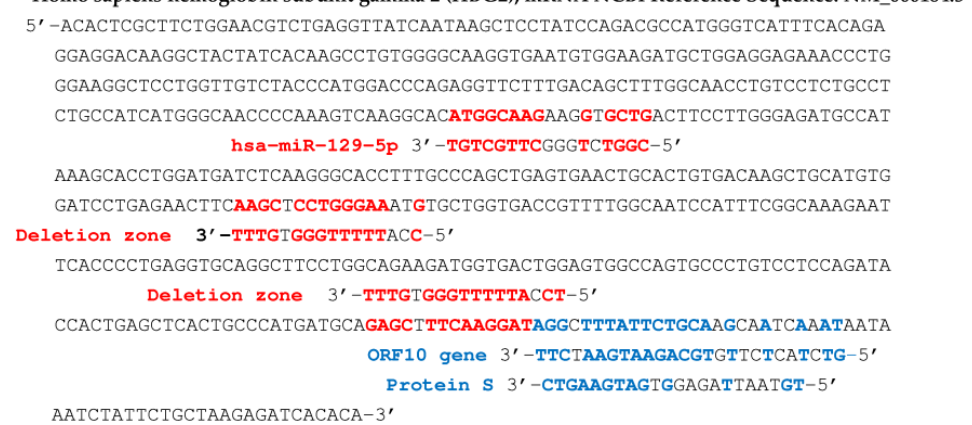
7 of 27 Figure 5. Mean concordance (in %) between the sequences of the miRs of the 5 ’ -UTR part (UnTrans- lated Region) of the host genome (blue for G. gallus and purple for H. sapiens), vector genome (yellow for A. gambiae) and a sequence at the top, of West Nile virus (WNV) UTR genome and at the bottom, of hepatitis C virus (HCV) UTR genome (from [43]). An example of the existence of accumulation of small RNA fragments exists in Scle- rotinia sclerotiorum infected with the SsHV2-L virus, and these small RNAs derived from the virus measure approximately 22 nt, the same length as the miRs, suggesting a cleavage by a protein Dicer-like [51]. Regarding SARS-CoV-2, such an influence on protein transla- tion has already been described [53 – 65], causing observed effects on the concentration of certain proteins, such as a dramatic decrease in hemoglobin [66 – 69]. If we assume that short RNA subsequences (about 20 nucleotides long), from the genes of the SARS-CoV-2 virus, can bind to Argonaut proteins and hybridize the mRNA of key human proteins, involved in metabolisms important as oxygen metabolism, it follows that recombinations,